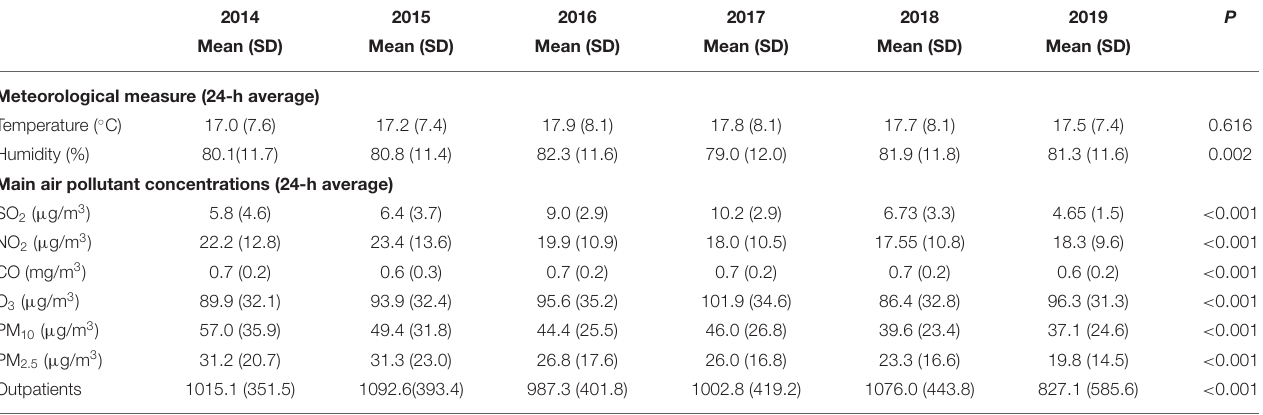
TABLE 1 | Descriptive statistics for the daily outpatient clinics, concentrations of air pollutants, and weather conditions.